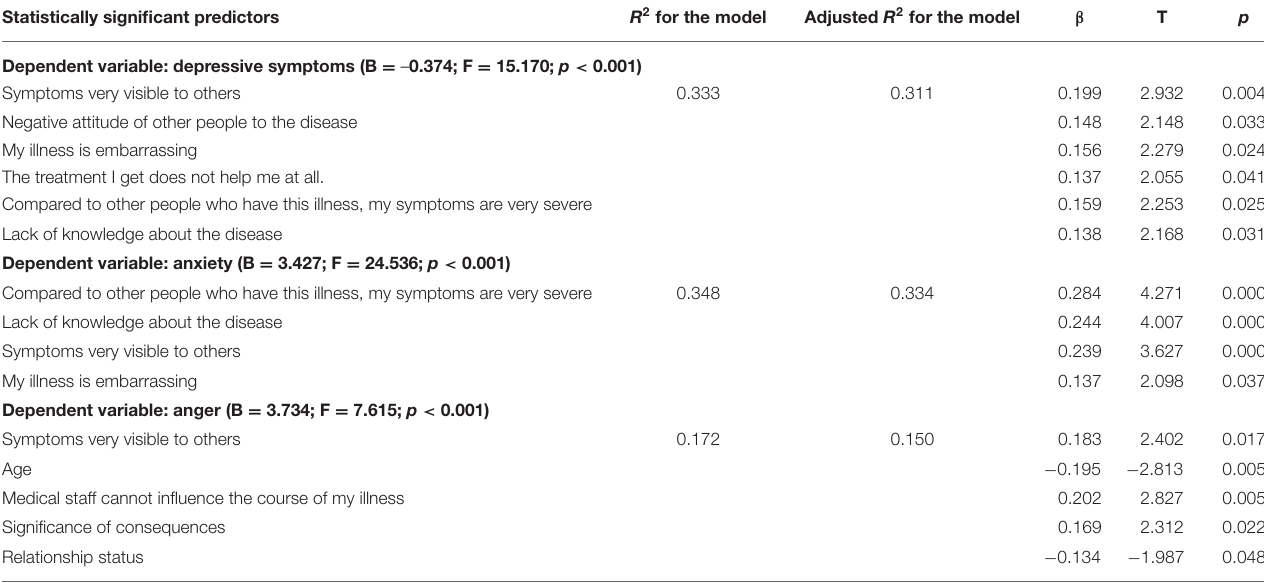
TABLE 5 | Predictors of the severity of ED symptoms in the group of women suffering from hypothyroidism—stepwise regression analysis. Statistically significant predictors R 2 for the model Adjusted R 2 for the model β T